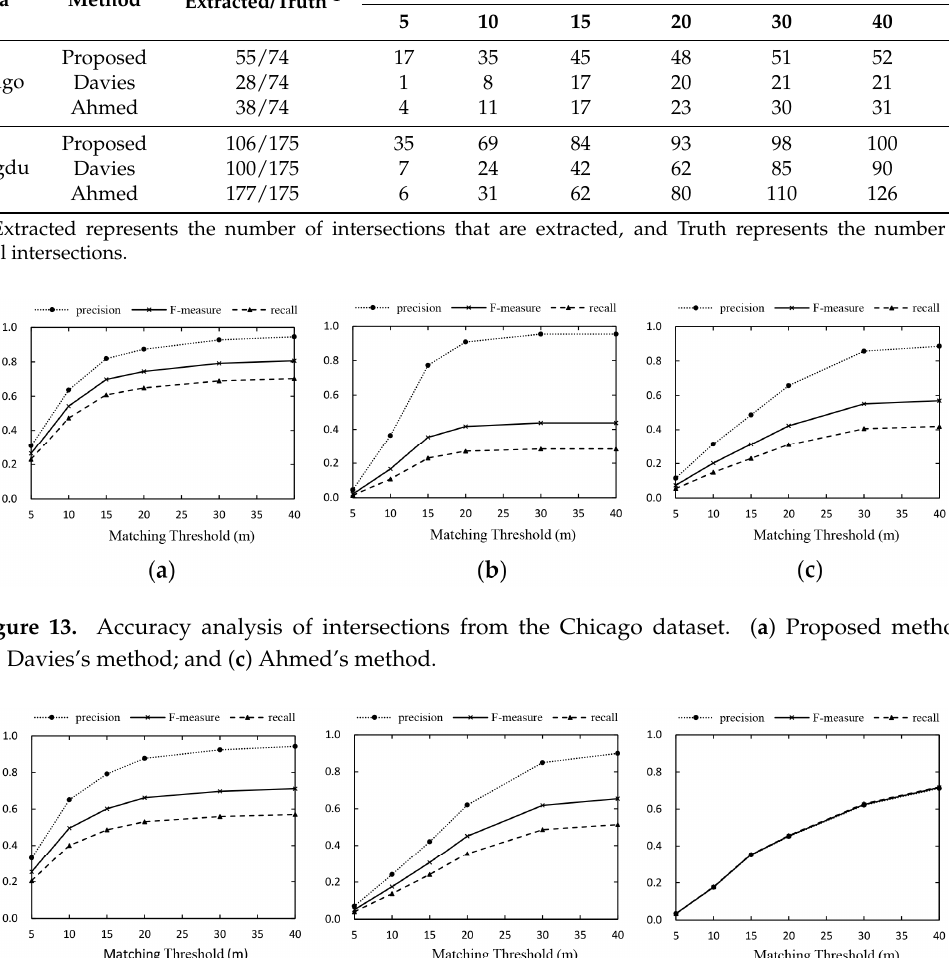
Table 1. Matched intersections with the threshold distance by the different methods. Area Method Extracted/Truth 1